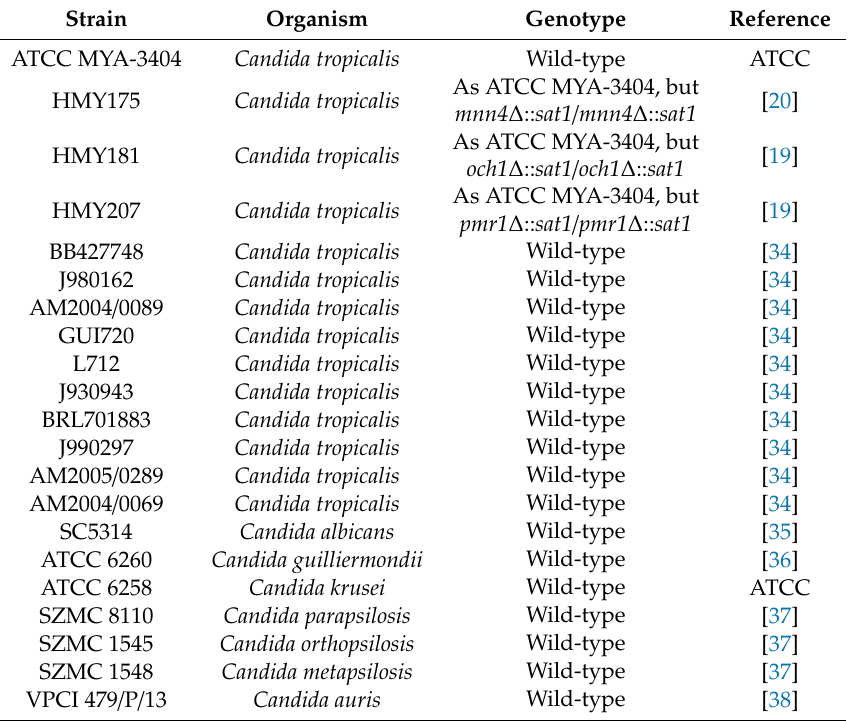
Table 1. Candida spp. strains used in this